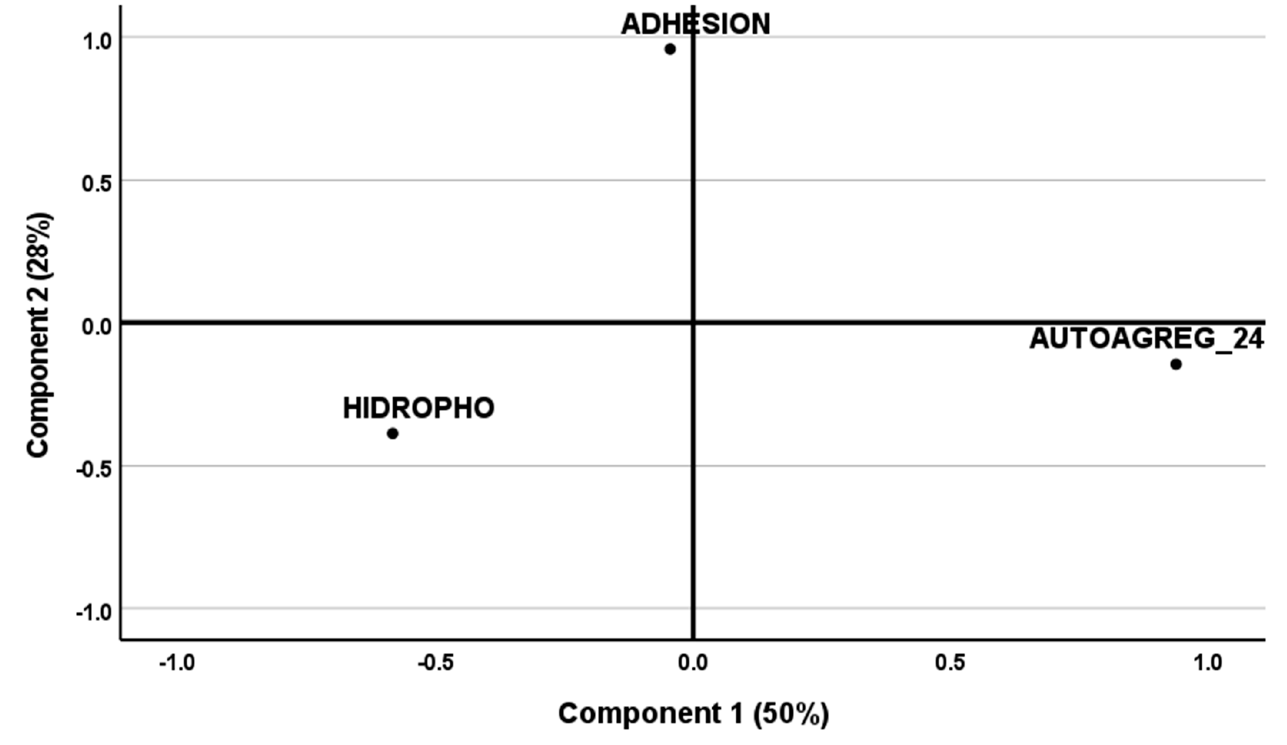
Figure 1. Plot of communalities from component extraction method, pertaining to probiotic characteristics associated with gastrointestinal tract.